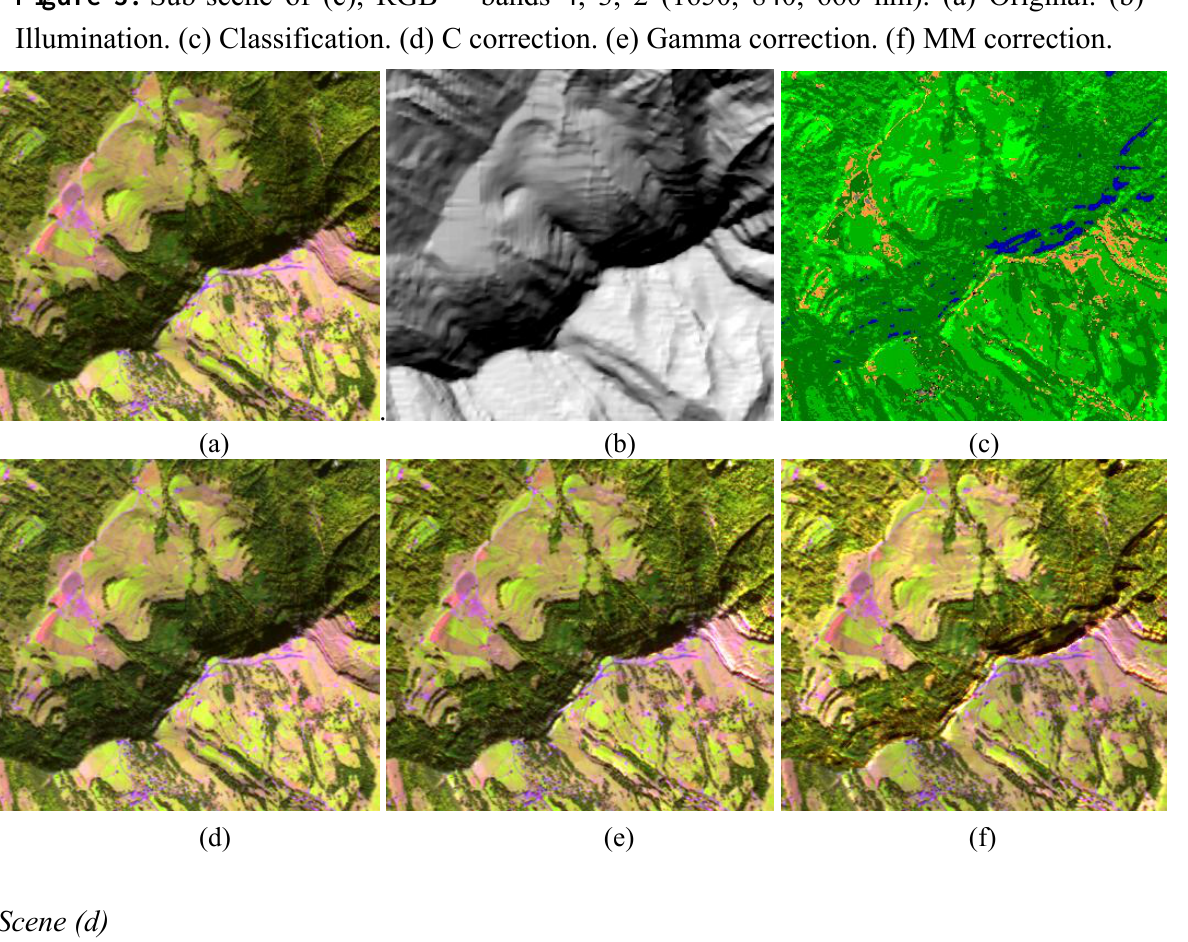
Figure 3. Sub-scene of (c), RGB = bands 4, 3, 2 (1650, 840, 660 nm). (a) Original.